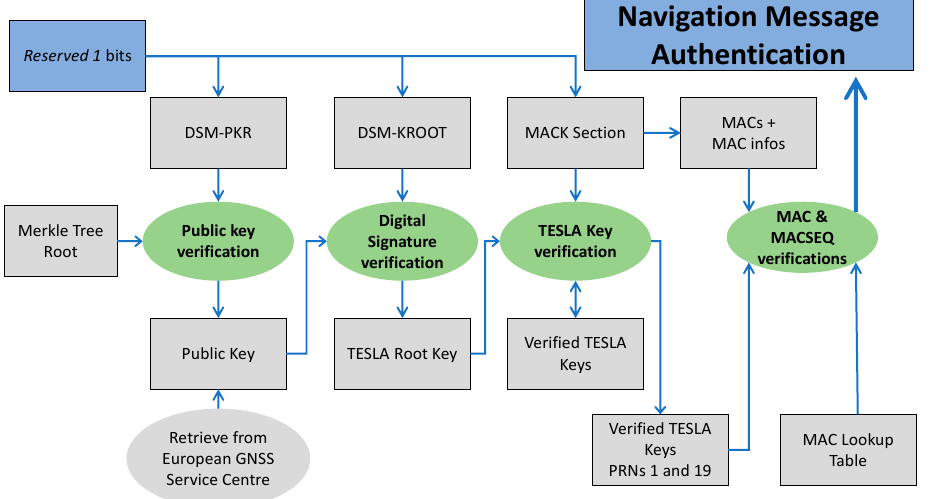
Figure 3. Simplified block scheme of the main OSNMA functionalities implemented in the receiver, adapted and restyled from [17].